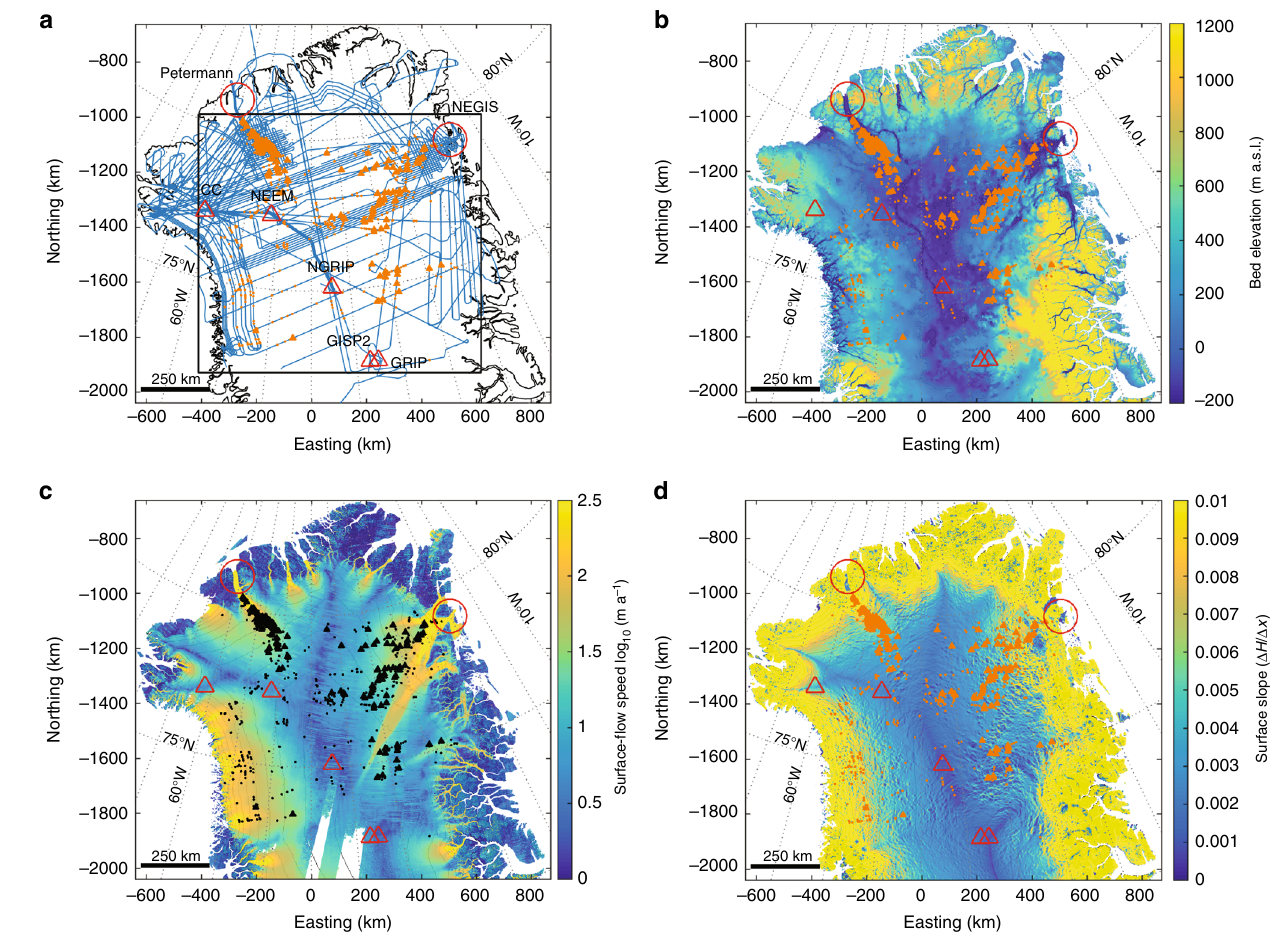
Fig. 1 Overview of mapped plume locations in North Greenland. Mapped locations of plumes ≥ H /3 ( fi lled triangles) and < H /3 ( fi lled circles), from NASA ’ s 2010 – 2014 Operation IceBridge fl ights 4 , and ice-core locations (red triangles; from NW to SE: Camp Century, NEEM, NGRIP, GISP2 and GRIP) together with Petermann glacier and Northeast Greenland Ice Stream (NEGIS; large red circle) are shown for all subplots. a Outline of North Greenland 46 together with 2010 – 2014 fl ight lines 4 (blue). Outlined area (black box) shows section used in Fig. 2 and Supplementary Figs. 2 and 3. b Bed topography 23,26 (additional contours at − 500, − 250 and 0 m.a.s.l.). c Surface topography 26 (250 m contours) superimposed by surface- fl ow speed 43 . d Surface-slope Δ